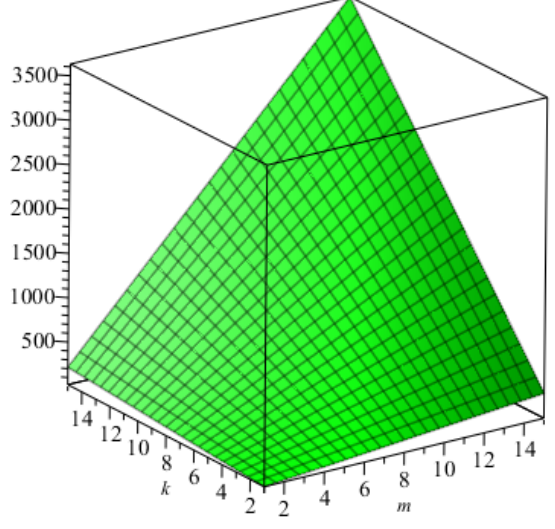
Figure 2. The graphically representation of total eccentricity index ζ of OX n